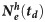
Inferences for variant fitness r and for the harmonic mean of effective population size Neh(td), for the 750 datasets simulated with five virus variants.(A) Correlation between true ri (x-axis) and estimated r^i (y-axis) (all variants considered together). (B) Correlation between true Neh (x-axis) and estimated N^eh (y-axis) (all sampling dates considered together, logarithmic scale). In both panels, the black line is the first bisector and the red dashed line is the best-fitting linear model. In panel A, the 9 points with r^i<0.7 correspond to datasets in which a highly counterselected variant was observed in only a few plants (5, on average, of the 48 plants) due to an initial low effective population size.